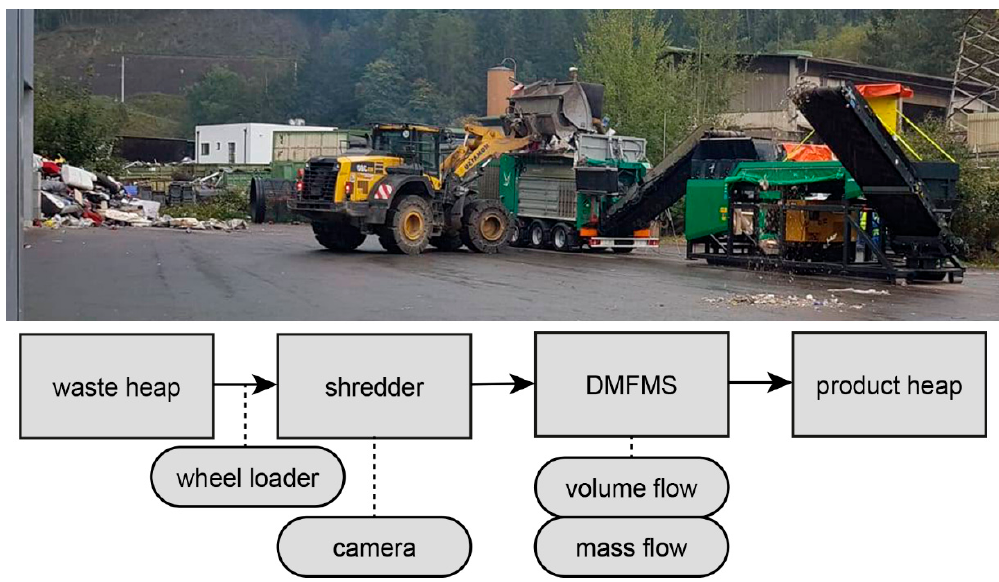
Figure A2. Experimental setup: photo and flow chart [24].